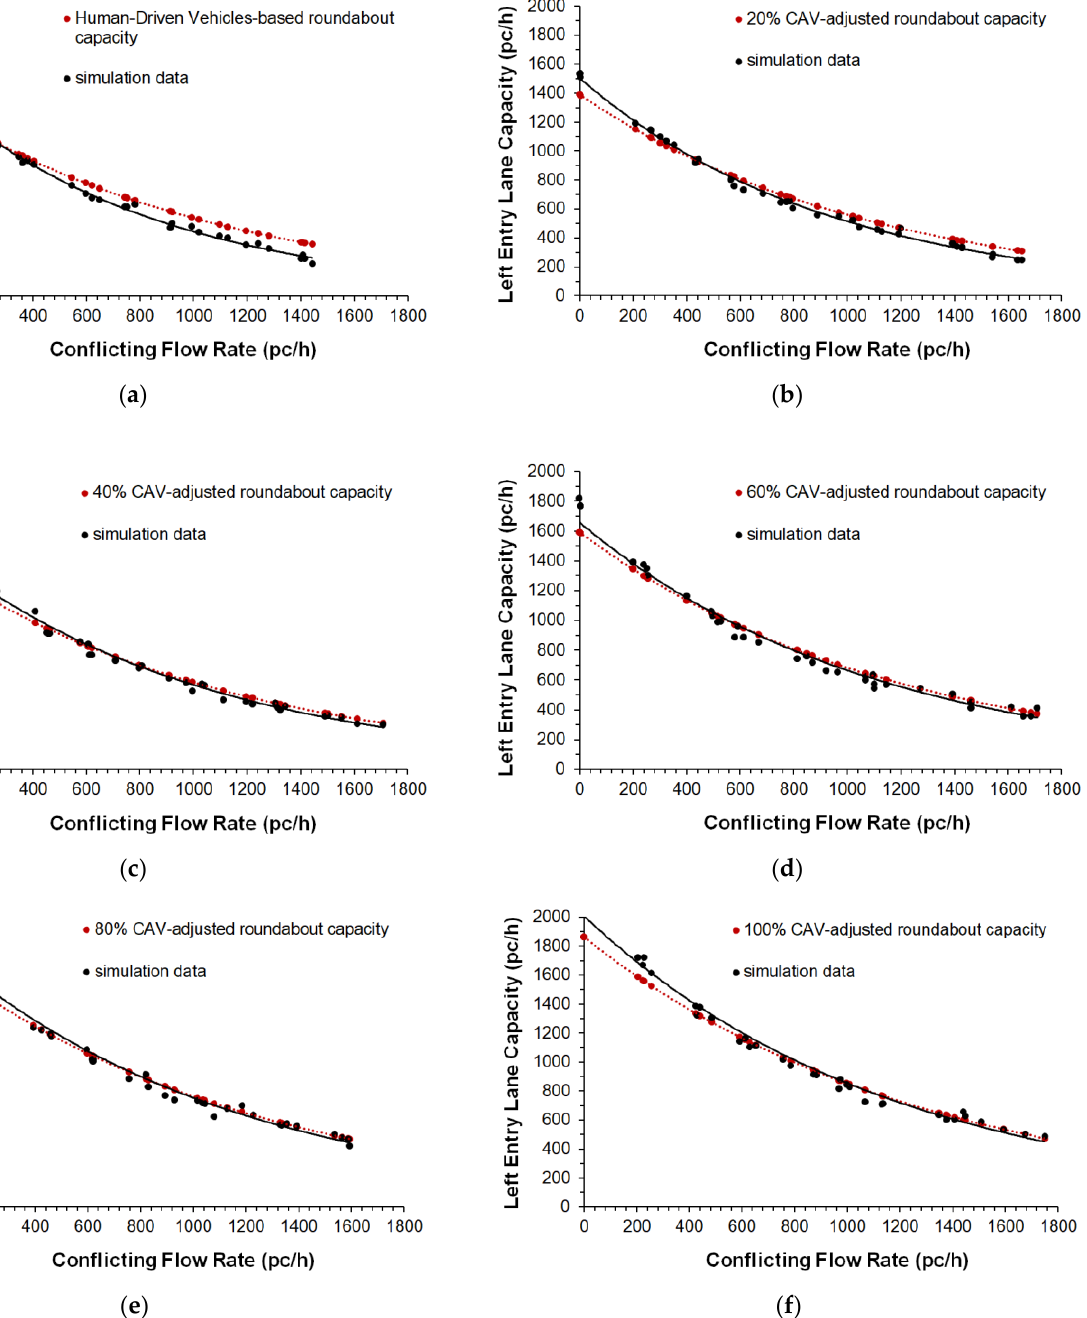
Figure 7. Comparisons between the CAV-adjusted and simulated entry capacity data for different market penetration rates of CAVs and HDVs for the entry mechanism 2 (i.e., the left entry lane of two-lane entry approach conflicted by two circulating lanes) listed as: ( a ) baseline scenario: 0% CAVs and 100% HDVs; ( b ) scenario 1: 20% CAVs and 80% HDVs; ( c ) scenario 2: 40% CAVs and 60% HVs; ( d ) scenario 3: 60% CAVs and 40% HDVs; ( e ) scenario 4: 80% CAVs and 20% HDVs; ( f ) scenario 5: 100% CAVs and 0% HDVs. Notes: to explain the entry mechanisms 2 reference has been made to the northbound left entry lane entry in Figure 4a; the black line and dotted red line regressions were extrapolated by the data.